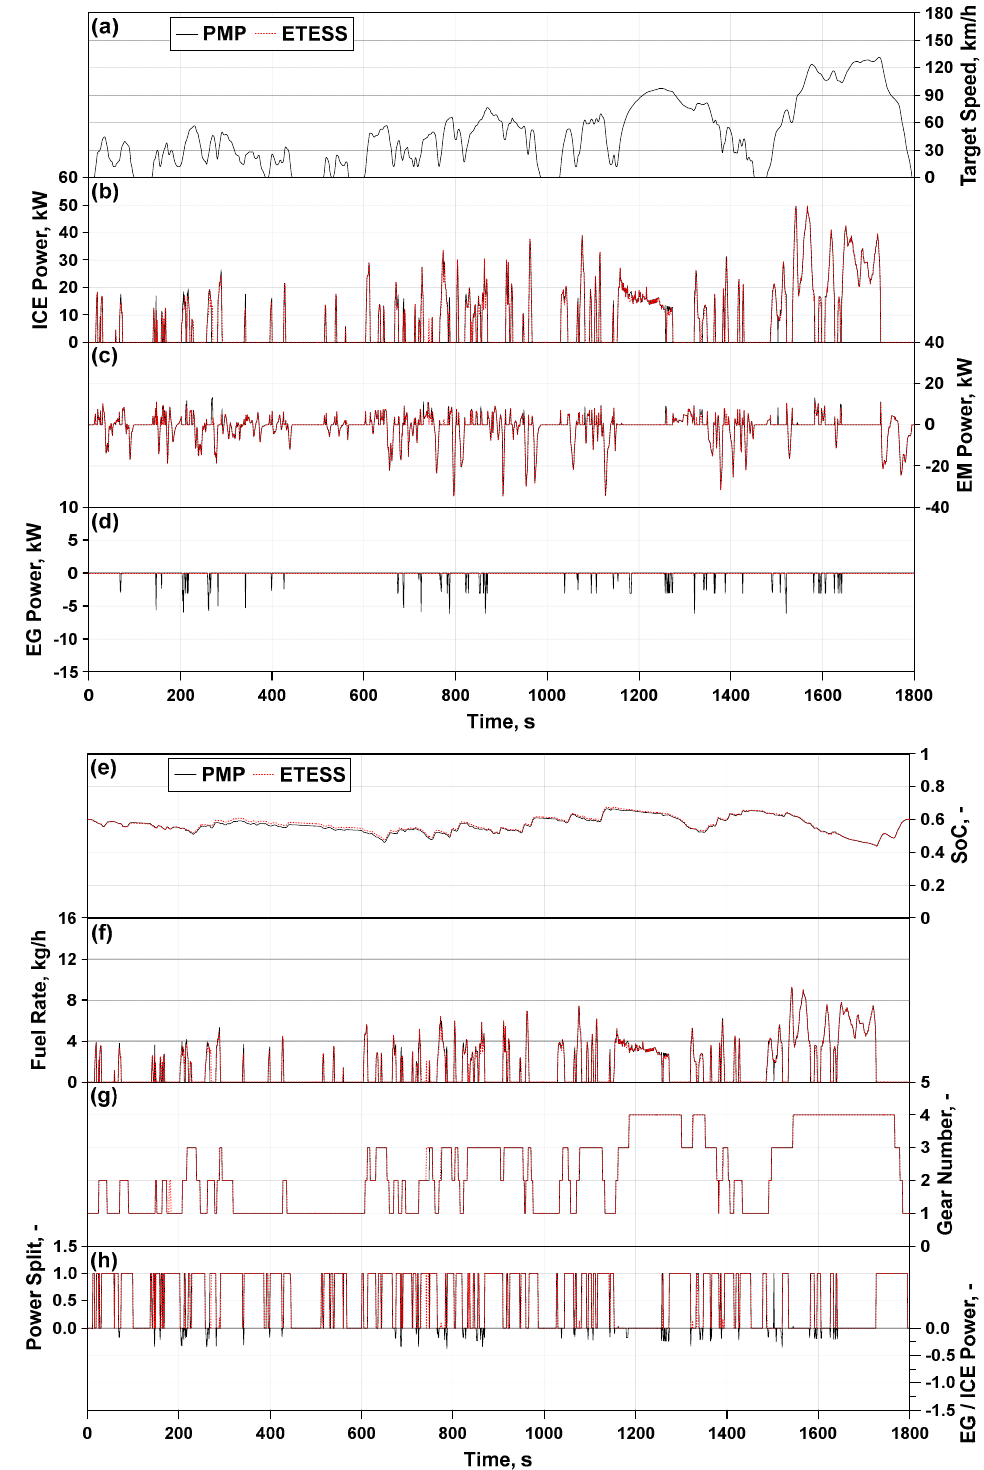
Figure 8. Pontryagin minimum principle (PMP)-ETESS comparisons of ICE power ( b ), EM power ( c ), EG power ( d ), SoC ( e ), fuel rate ( f ), gearboxes (GB 1 ) number ( g ) and vehicle mode ( h ) along the WLTC (vehicle speed—( a ))—case #1.